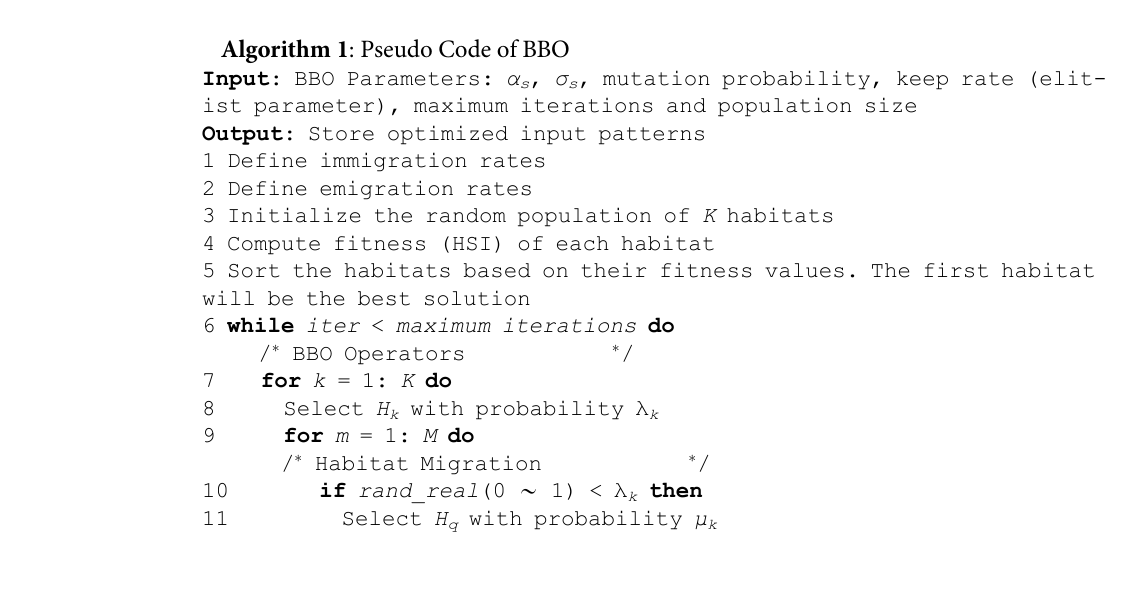
Algorithm 1 : Pseudo Code of BBO